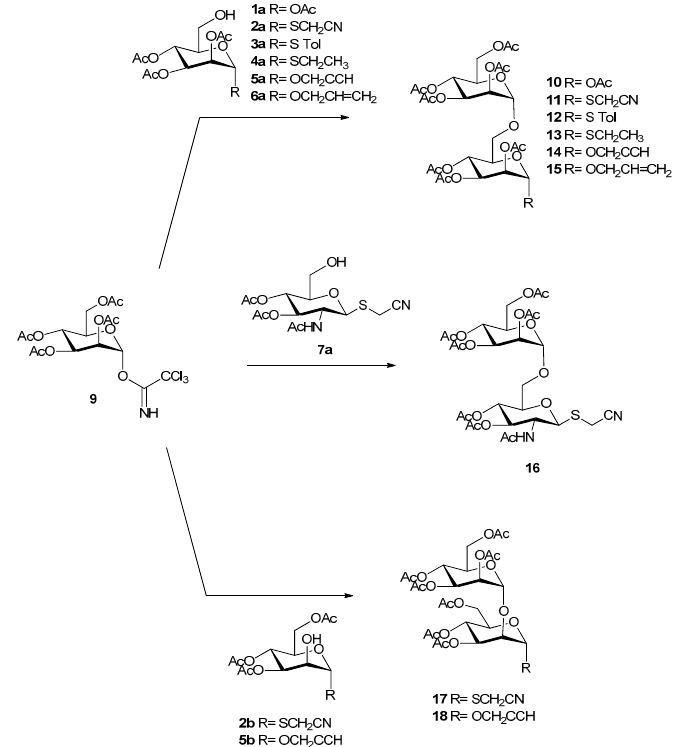
Table 3. Reaction conditions for disaccharides